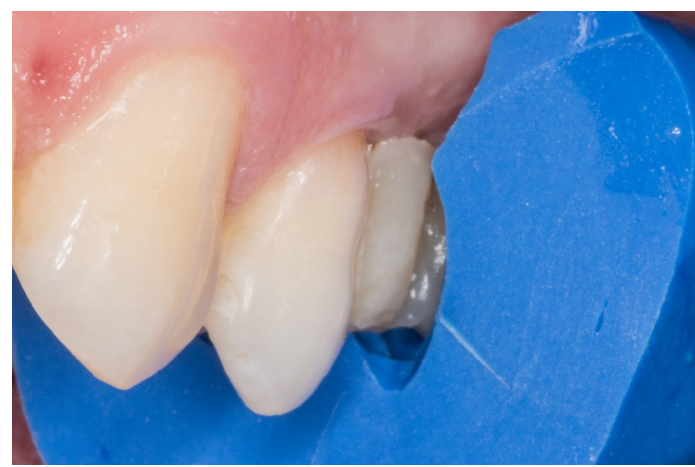
Figure 6. The crown of the pontic and the occlusal surfaces of the inlay preparations were formed incrementally using a key silicone.